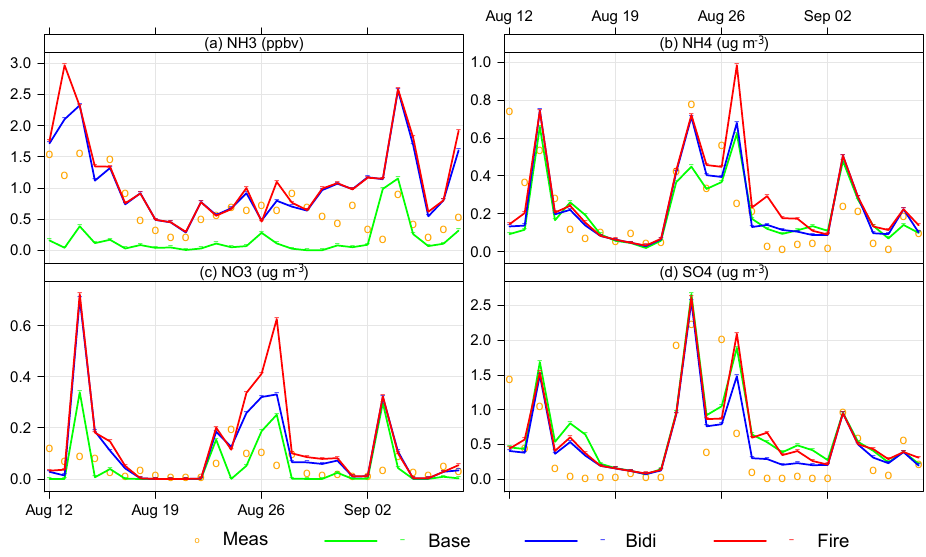
Figure 4. Surface daily average VMR of (a) NH 3 , and concentrations of (b) fine particulate NH + ground site in the AOSR. Measurements (Meas) in orange, base model in green, bidirectional flux model (Bidi) in blue, and fire + bidi model (Fire) in